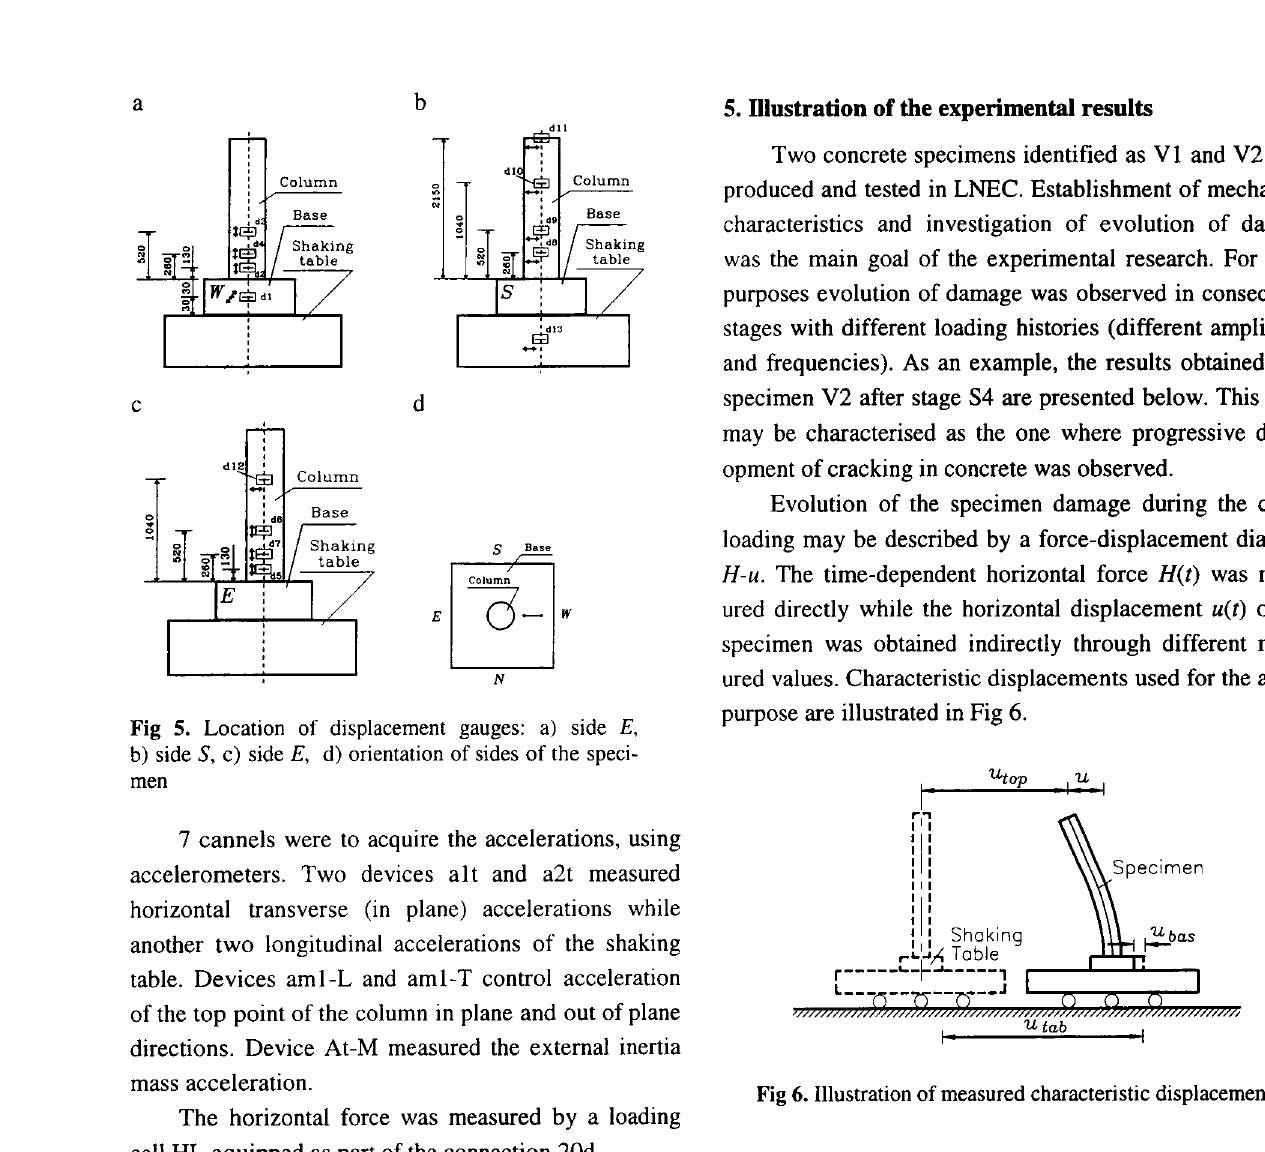
Fig 6. Illustration of measured characteristic displacements Transverse displacement of the specimen u(t) may be expressed as the difference between the displacements at the top and the bottom. The top displacement Urop is re corded directly. The bottom displacement is the controlled displacement of the shaking table Urab corrected by the rela tive displacement of the specimen base in respect of shak ing table ubas· Finally, the transverse displacement of the specimen may be expressed